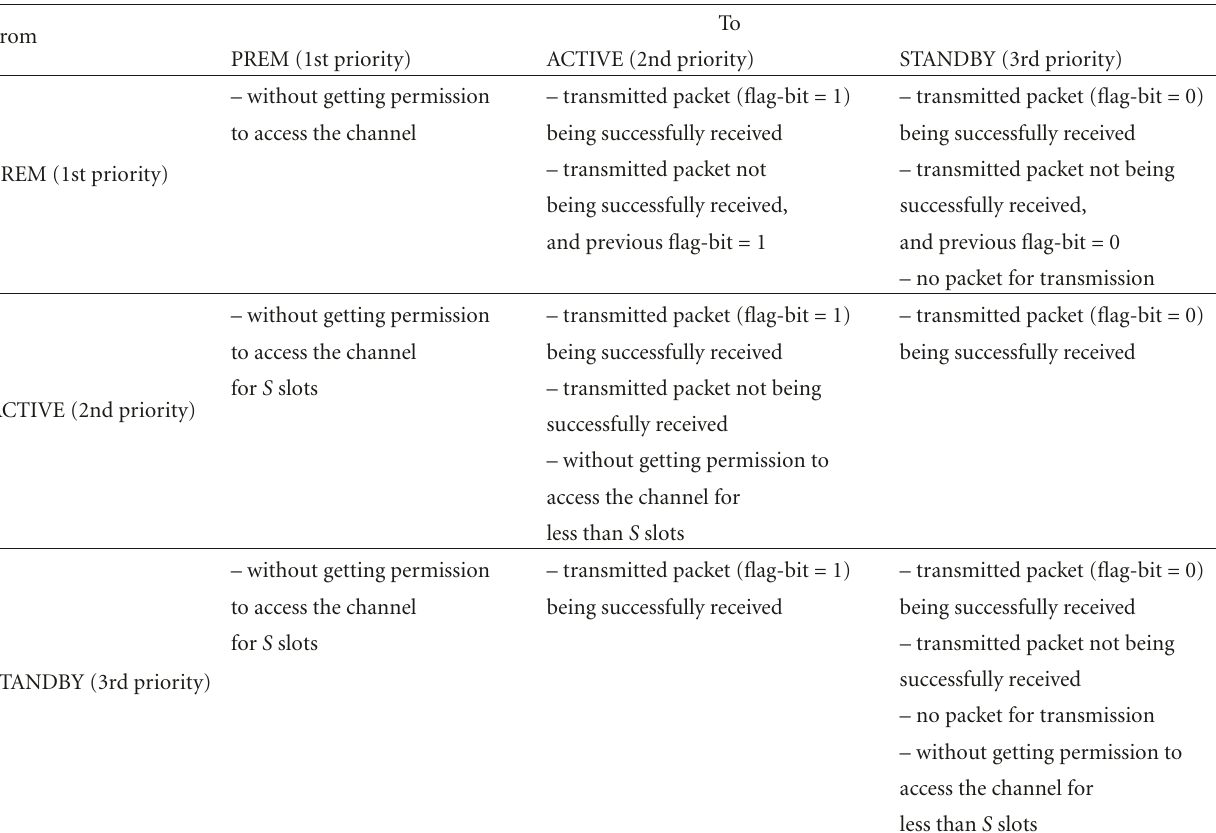
Table 1: Transition conditions among three di ff erent priority